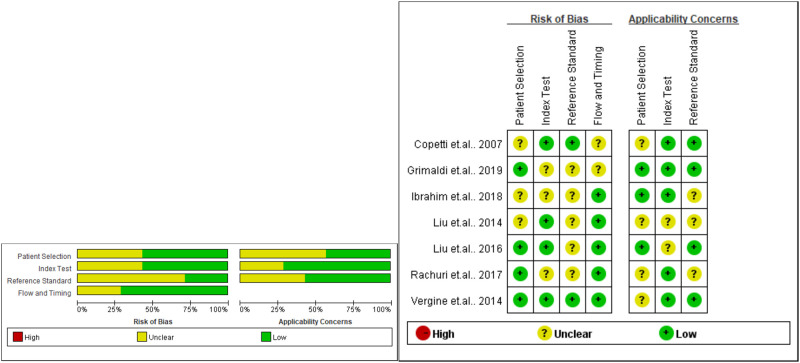
Risk-of-bias assessment of included studies.